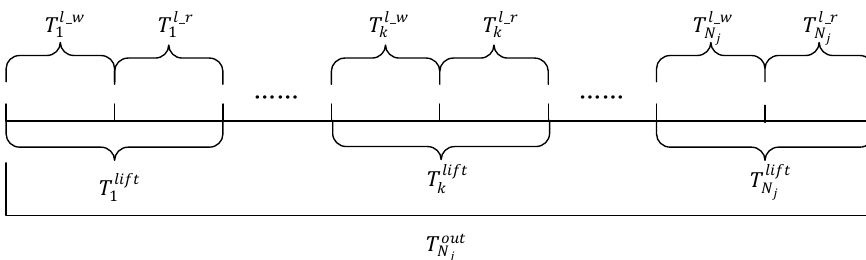
Figure 5. The serial operation time sequence of lift.